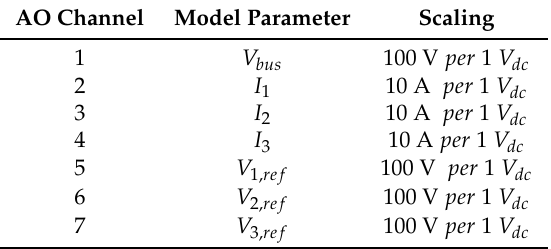
Table 6. Hardware-in-the-loop (HIL) Analog Output Configuration.